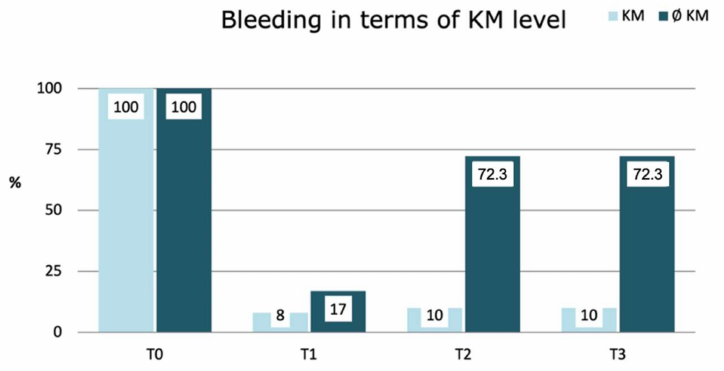
Figure 3. Changes in bleeding prevalence according to KM Level: Simple logistic regression results with GEE